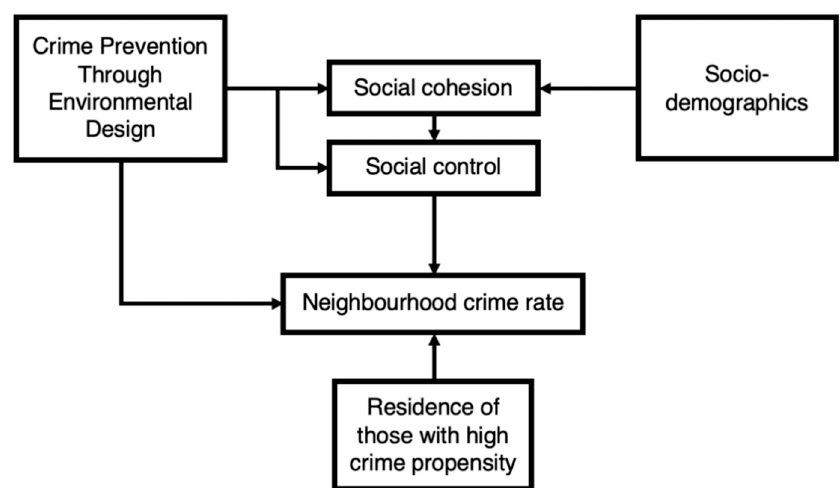
Figure 1. A pathway model illustrating the potential dual influence of physical and social features of neighbourhoods on crime. Potential pathways of influence are deduced from theoretical and empirical research findings to be discussed below, revealing the need for greater specificity of purported influences.